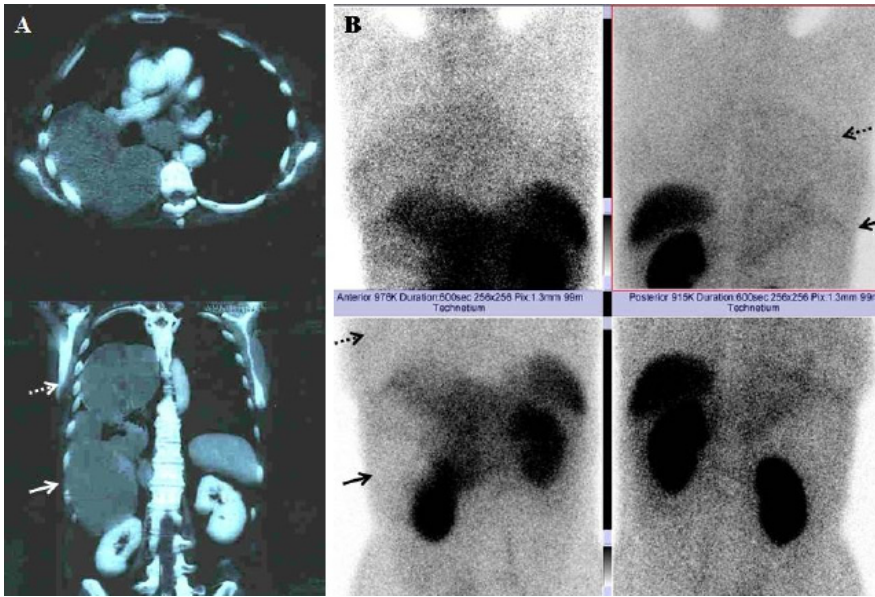
Figure 3: Well differentiated neuroendocrine carcinoma. Lung carcinoid with liver metastasis (Ki 67-8%). A: MRI demonstrates huge right lung lesion (dotted white arrow) with large liver metastasis (solid white arrow). B: Sequential spot Tc-99m-Tektrotyd scan of thoracal and abdominal regions shows absence of tracer accumulation in the lung lesions (dotted black arrow) and liver “cold” lesions (solid black